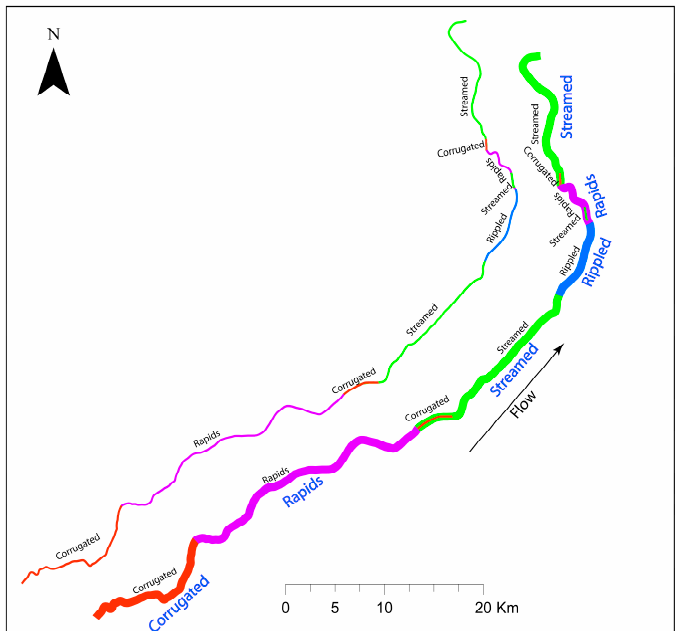
Figure 10. Example of application of the “Holistic categorical” algorithm for the Cauca river (Magdalena basin), for the attribute “current” (which can assume the values: “rapids, corrugated, pool & ri ffl e, streamed, rippled, plane surface, not detectable”). Left: original values (with black labels) along a stretch, which can sometimes refer to very short segments. Right: the same stretch after the application of the proposed categorical holistic algorithm in thick line over the original thin line (same one of the left figure): it can be seen that the number of segments has now been significantly reduced (blue labels with larger font), no segment is shorter than the adopted significant length L S , and the reaches that were “engulfed” are those that were originally the